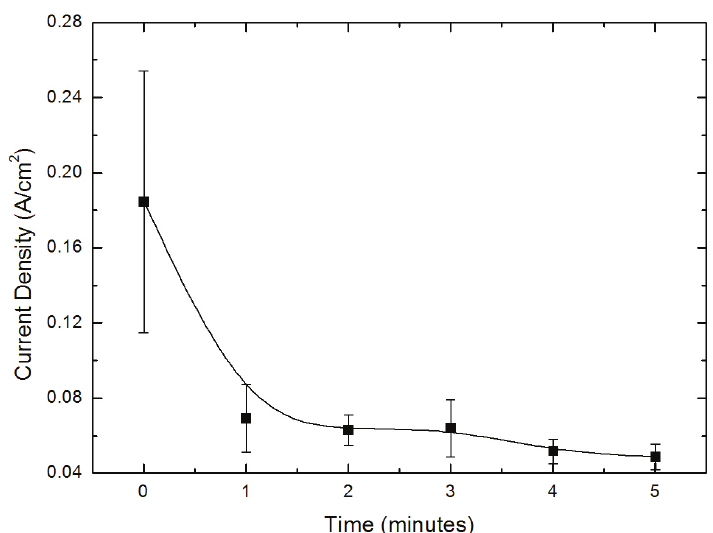
Figure 4. Current density as a function of treatment